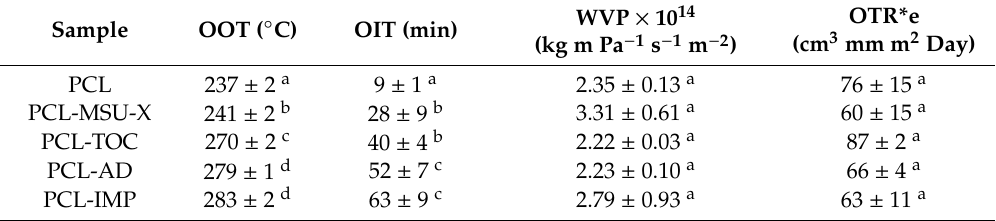
Table 3. OOT and OIT (DSC, O 2 atmosphere); WVP and OTR*e parameters in PCL-based